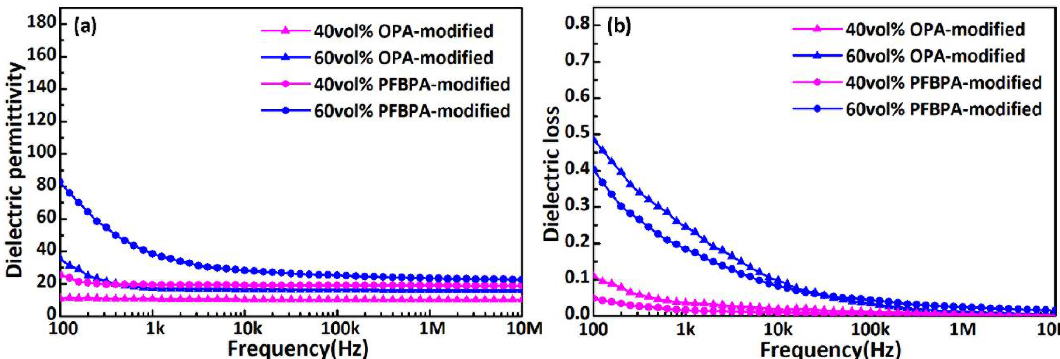
Figure 6. Frequency dependence of ( a ) dielectric permittivity and ( b ) dielectric loss for nanocomposites at 40 vol % and 60 vol % nanoparticles loading with OPA-modified and PFBPA-modified Ag/TiO 2 filler at room temperature.